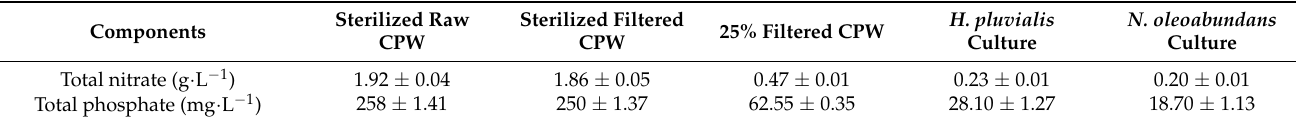
Table 4. Removal of nitrate and phosphate from the CPW after 15 days of cultivation.